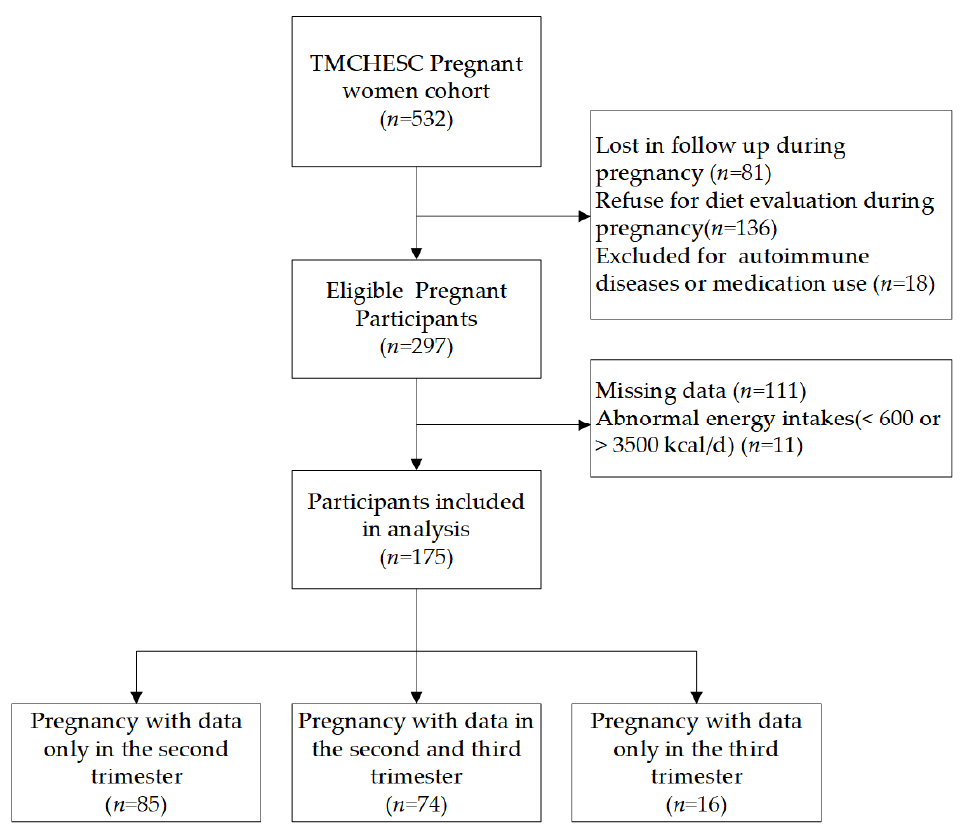
Figure 1. Flow chart of sample selection in this study.